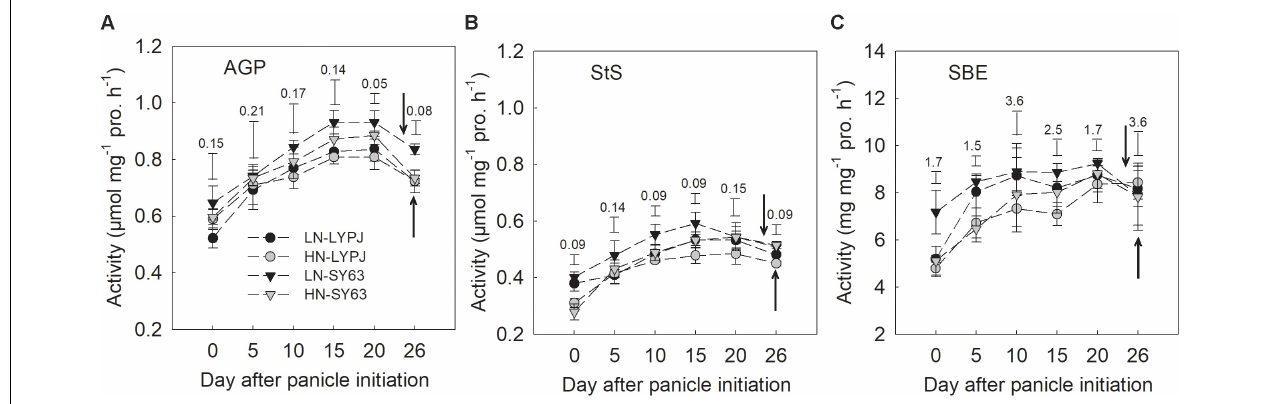
FIGURE 5 | Activities of AGP (A) , StS (B) , and SBE (C) in the stems of LYPJ and SY63 cultivars under LN and HN treatments. Vertical bar with number represents LSD